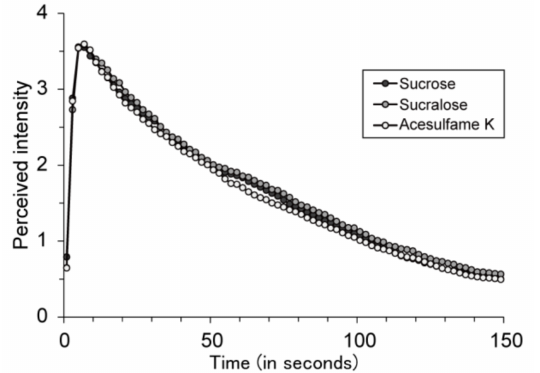
Figure 2. Temporal profiles of sweetness of each sweetened coffee beverage. Temporal profiles of sweetness were obtained for 150 s after participants swallowed sweetened coffee